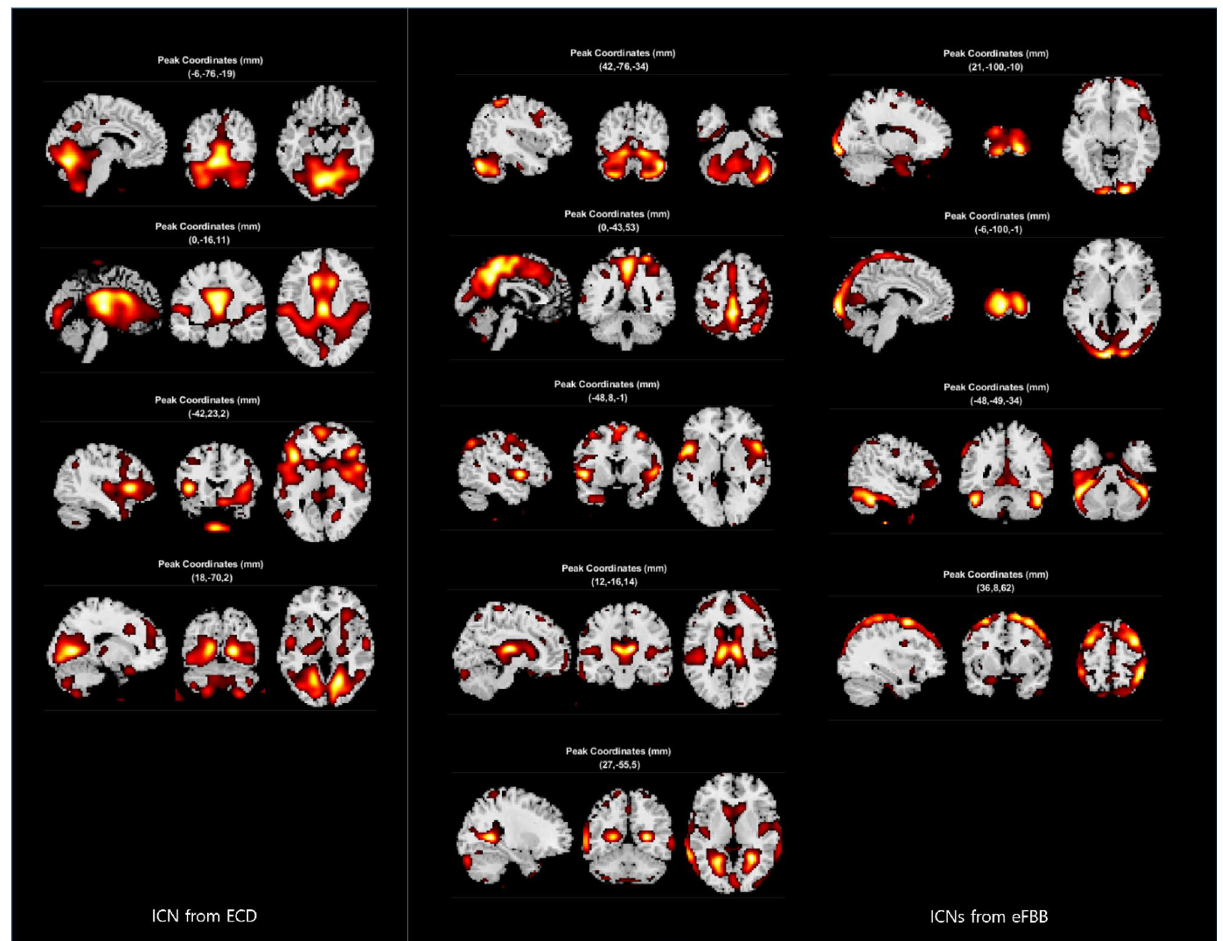
Figure 5. The intrinsic connectivity networks identified from ECD SPECT and eFBB PET. The images in the 1st column show the intrinsic connectivity networks derived from ECD SPECT, and the 2nd and 3rd columns from eFBB PET. Abbreviations ECD SPECT, Tc-99m ethyl cysteinate dimer single photon emission computed tomography; eFBB PET, early-phase F-18 Florbetaben positron emission